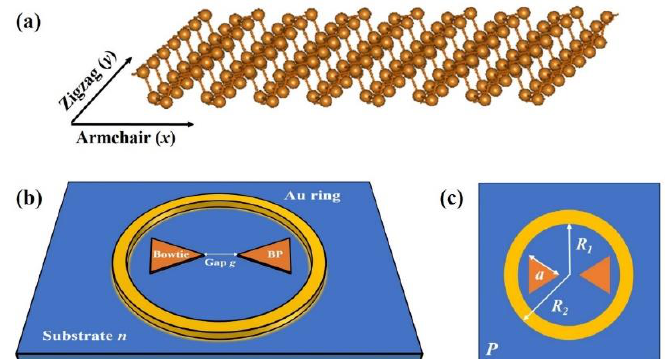
Figure 1. ( a ) Schematic diagram of BP crystal structure. ( b ) The three-dimensional schematic of Fano sensor based on BP bowtie coupled with Au ring structure. The gap distance between the neighboring bowtie BP structures is g . ( c ) The top view of bowtie BP coupled with Au ring structure. The inner radius of the ring is R 1 and outer radius is R 2 , and the side length of the BP bowtie is a .